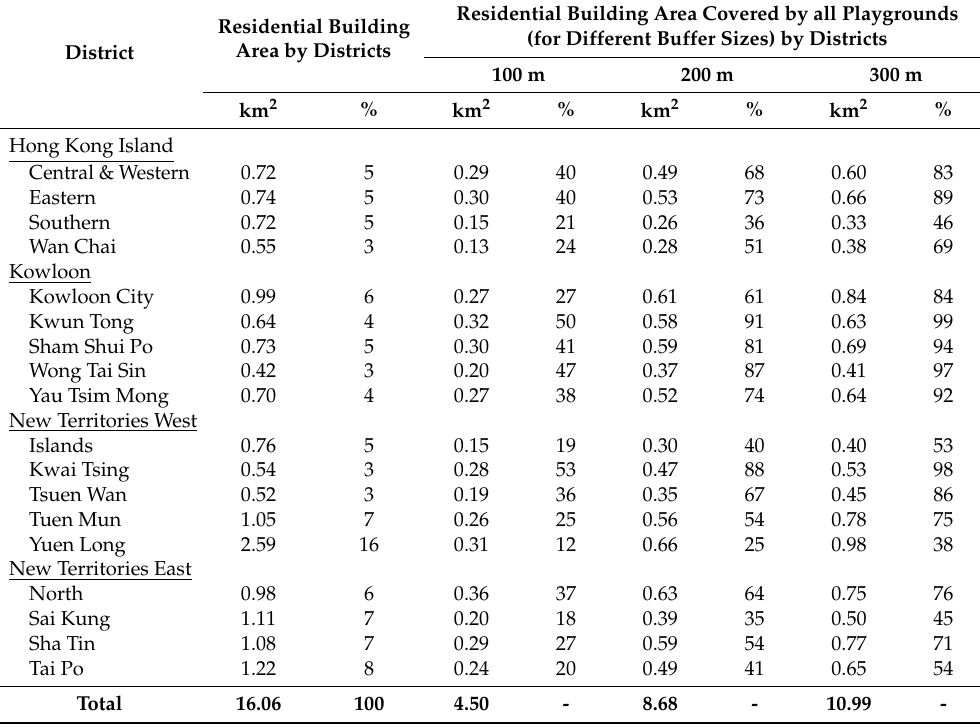
Table 3. Proximity analysis of playground coverage by 18 districts of Hong